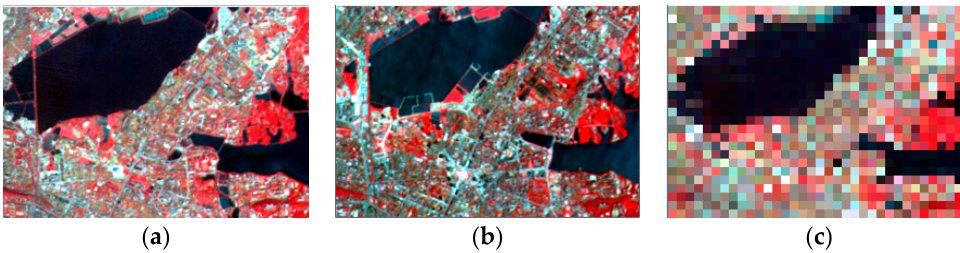
Figure 5. The original and synthetic Landsat Thematic Mapper (TM) images. ( a ) and ( b ) show the high resolution (HR) multispectral image (280 × 200 pixels) composed with band 4, 3, and 2 in 1986 and 2000, respectively. ( c ) shows the low resolution (LR) image in 1986 generated by degrading the HR image with a scale factor of 8.